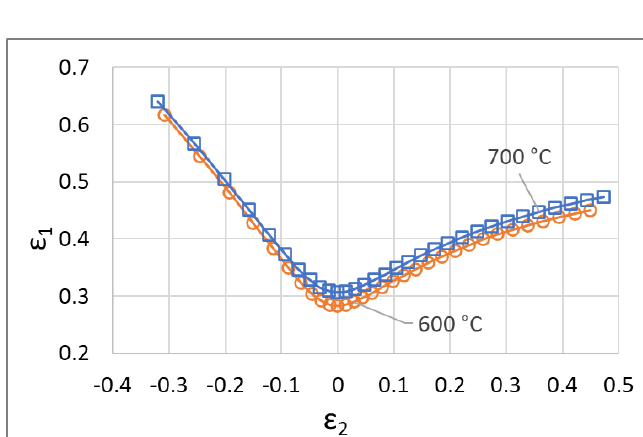
Figure 5. FLC for USIBOR ® 2000. Table 4. Thermal properties for USIBOR ® 1500. Figure 4. FLCs for USIBOR ® 1500.